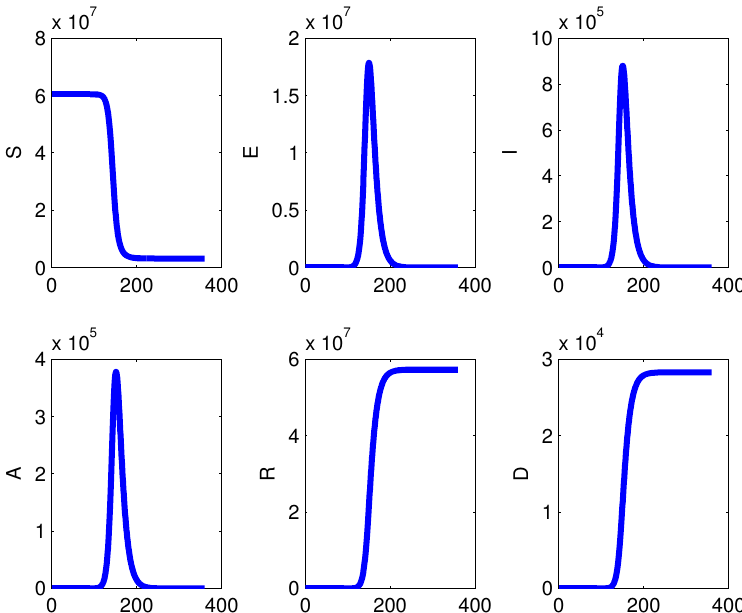
Figure 18. The total populations with the lock-down policy, implemented from time 1 up to time 30, with the reduced contact rate β I = 10 − 10 , after which β I = 10 − 7 resumes. The simulation runs over a one year timespan for the simplified model with no demographics (1) where we take Λ = 0, d p = 0. Left to right and top to bottom, the subpopulations are: S , E , I , A , R and D , the disease-related deceased